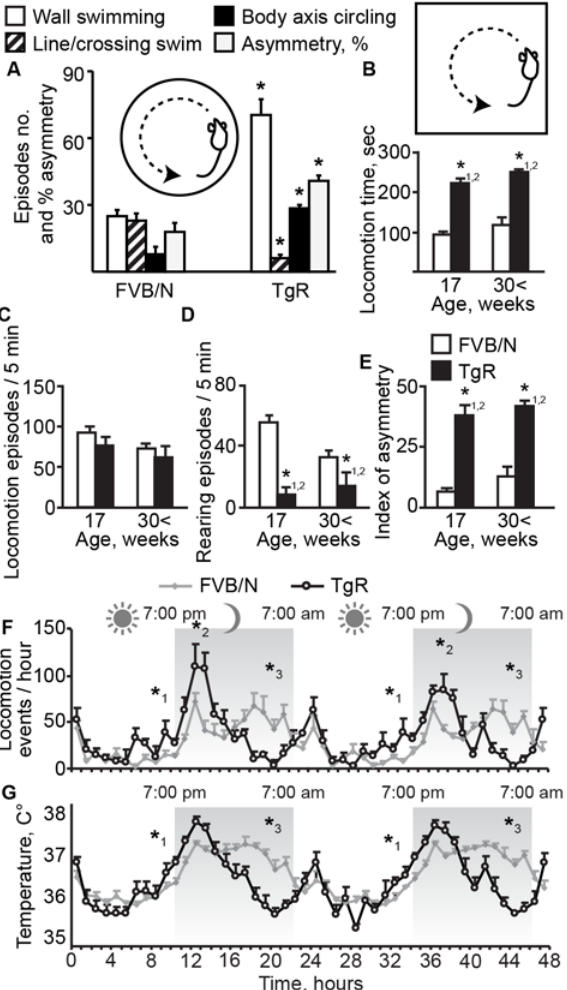
Figure 1. TgR mice show SB profiles. ( A ) Forced swim test. Shown are wall swim (number of swims around the circumference of the circular pool), line/crossing swim (number of episodes in which the mouse made a straight- line path instead of adhering to the wall), body axis circling (lateral circling in the water around the body axis) and asymmetry % (index of asymmetry in direction of swimming; 0 = perfect symmetry, 50% = complete 0 = perfect symmetry, 50% = complete asymmetry). Sample sizes: FVB / N ( n = 10), TgR ( n = 14). asymmetry). Sample sizes: FVB/N ( n = 10), TgR ( n = 14). ( B – E ) Open field tests. Shown are locomotion time, ( B – E ) Open field tests. Shown are locomotion time, episodes, rearing events and the index of asymmetry. episodes, rearing events and the index of asymmetry. ( F – G ) Circadian light: dark rhythm and body temperatures ( F , G ) Circadian light: dark rhythm and body temperatures in TgR and FVB / N mice. Sample sizes: in TgR and FVB/N mice. Sample sizes: FVB/N ( n = 8), TgR ( n = 6). Asterisks represent significant ANOVA: * 1, * FVB / N ( n = 8), TgR ( n = 6). Asterisks represent significant ANOVA: * 1, * 2, * 3, in the first, second, and 2, * 3, in the first, second, and third quarters respectively. third quarters